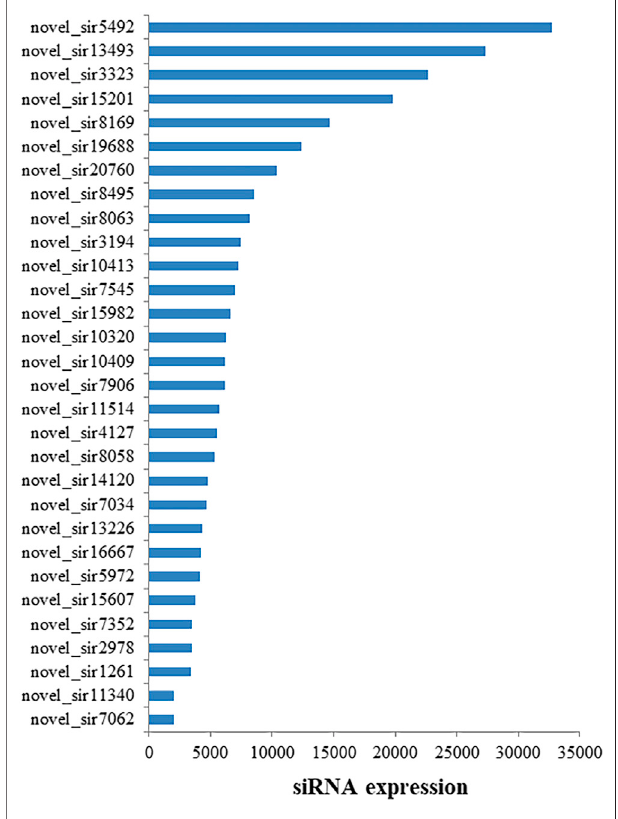
FIGURE 2 | Abundantly expressed siRNAs in fl owering Chinese cabbage. siRNA expression is shown in transcripts per million